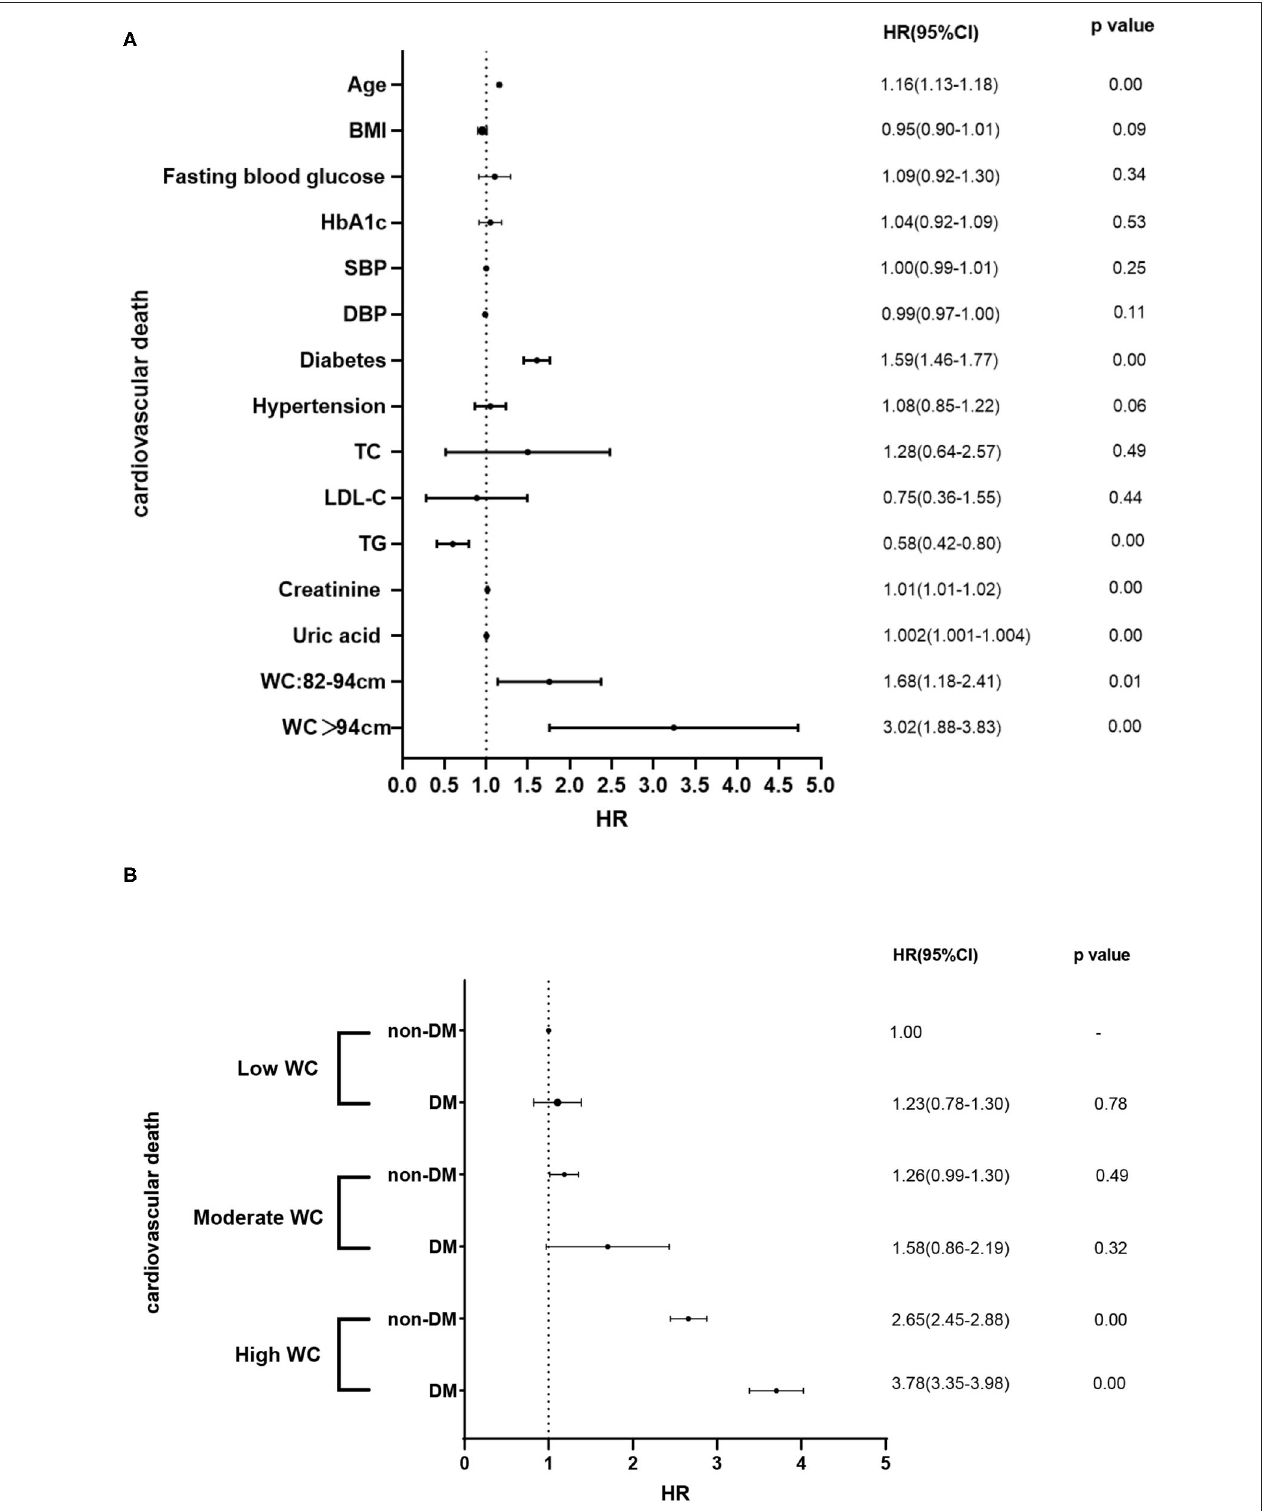
FIGURE 4 | (A) Associations of clinical confounders and the prevalence of cardiovascular death. (B) Associations of different degrees of WC and DM and the prevalence of cardiovascular death in different subgroups.